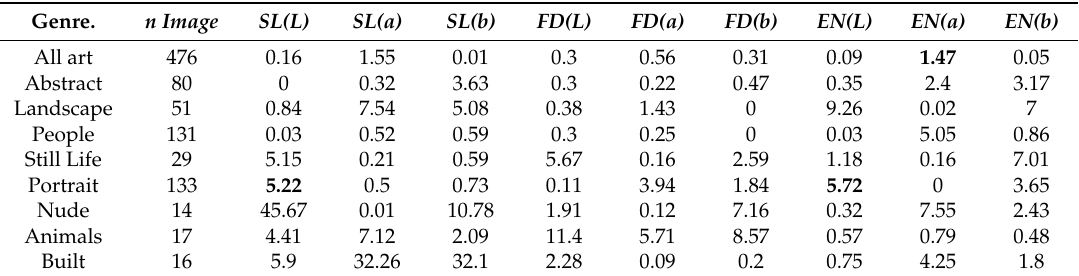
Table 1. Summary of correlations between image statistics (columns) and aesthetic ratings of paintings in di ff erent genres (rows).